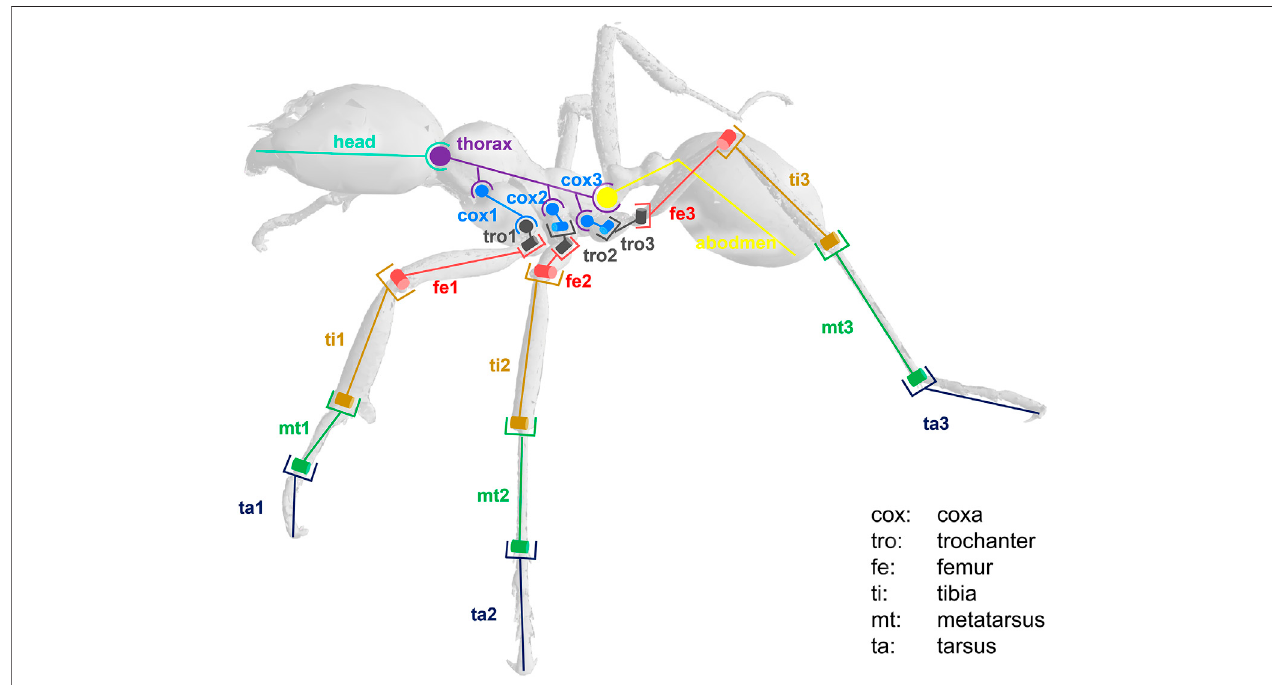
FIGURE 3 | Kinematic chain representing half of the ant locomotor system. Anatomy: th (thorax), pet (petiole), abd (abdomen), cox (coxa), tro (trochanter), fe (femur), ti (tibia), mt (metatarsus), ta (tarsus). Type of joint: hinge (example: mt/ta) or ball and socket (example: head/thorax).